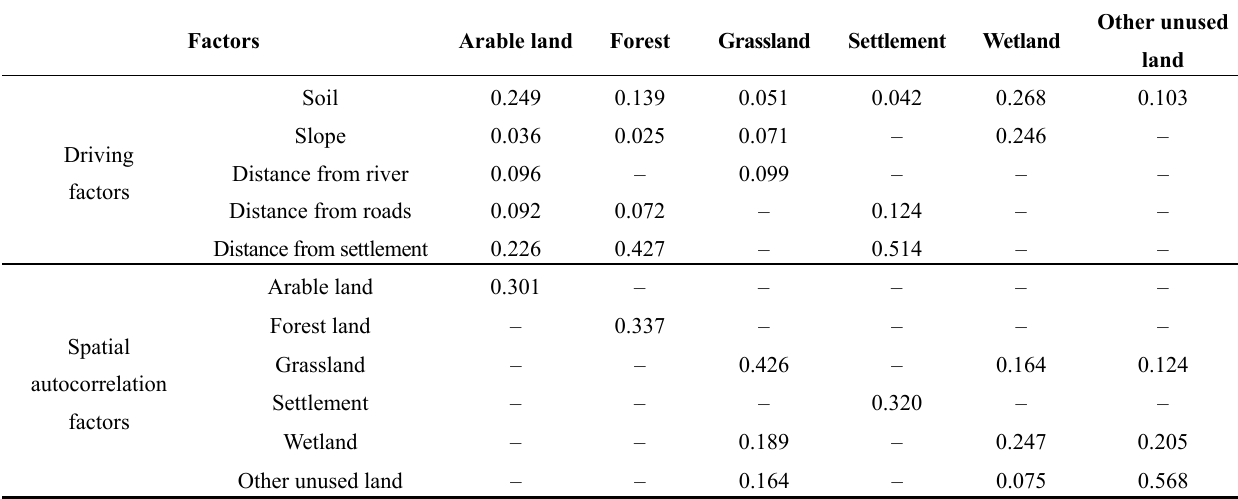
Table 2. Factors and their weights used for construction of suitability